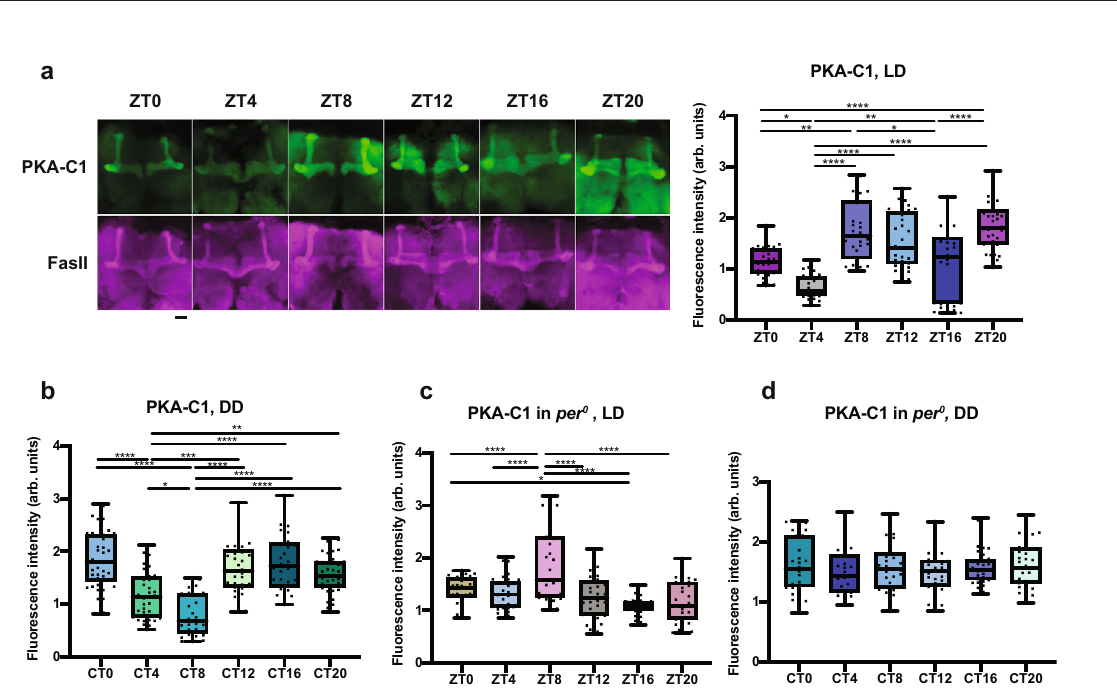
Fig. 2 Screening for MB LD-DD cyclers involved in sleep. a The total daily sleep of male fl ies expressing an RNAi transgene with the OK107 driver or w 1118 . The center lines indicate the median, box boundaries are 25th and 75th percentiles, and the whiskers represent the minimum and maximum values. The total amount of sleep per day was compared with OK107/ + using the one-way ANOVA with Dunnett ’ s multiple comparisons test (* p < 0.05, ** p < 0.01, **** p < 0.0001; n = 13 – 32 fl ies per group). Source data are provided as a Source Data fi le. b RNA-seq pro fi les of genes that increase sleep upon knockdown in the MB in males. Each data point represents the normalized RPKM of the indicated gene in one replicate. Connecting lines represent the means of data points. X -axis indicates ZT or CT. RNA-seq pro fi les in LD and DD are displayed in red and blue, respectively. c RNA-seq pro fi les of Nf1 and Pka-c1 genes in the MB neurons in per 0 mutant fl ies collected during DD2. Data are presented as in c .